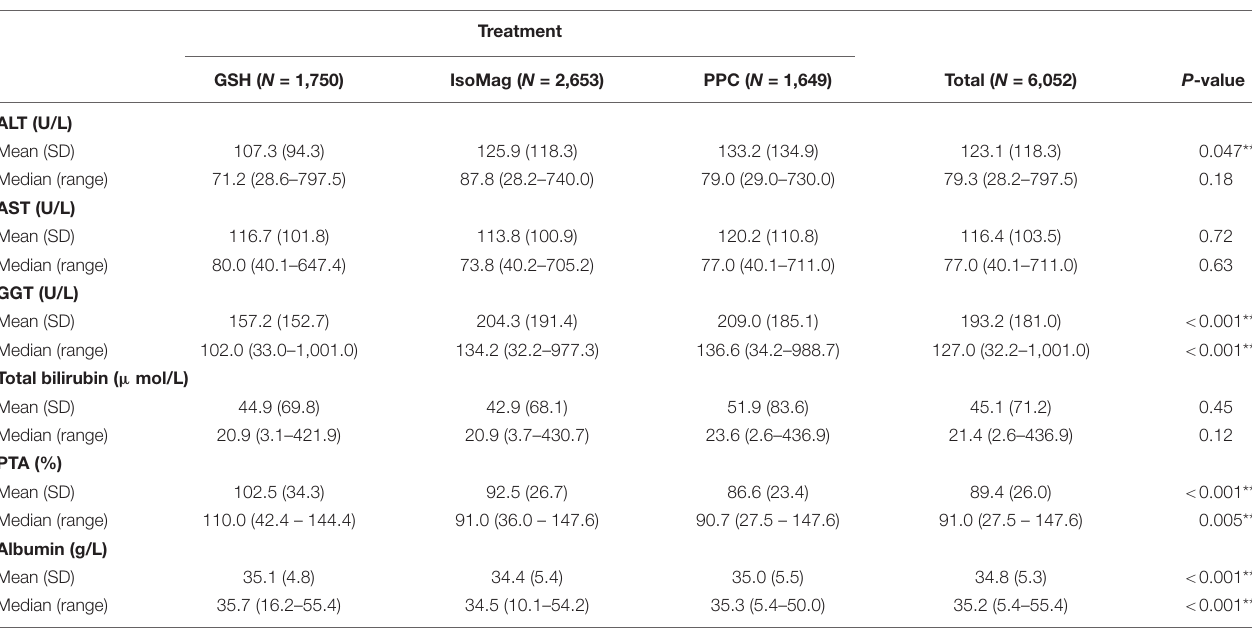
TABLE 3 | Baseline liver function test by treatment groups.